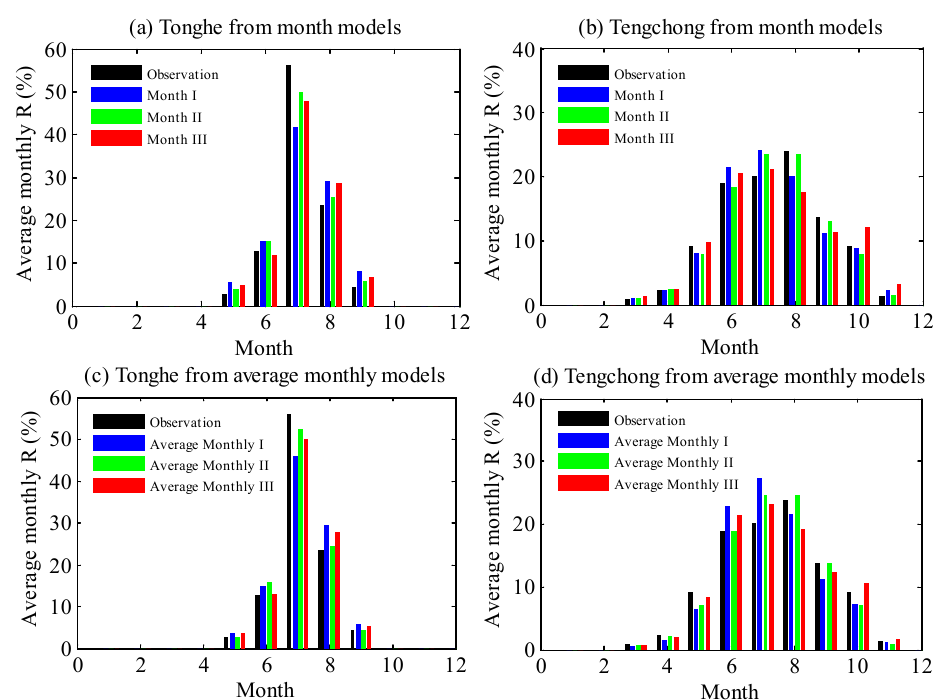
Figure 3. Comparisons of average monthly R values between observation values calculated using 1min resolution rainfall data and estimated values using month models (a, b) and average monthly models (c, d) for the Tonghe and Tengchong